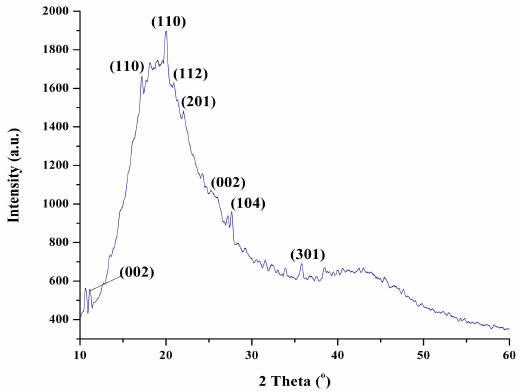
Figure 8. XRD pattern of sample containing